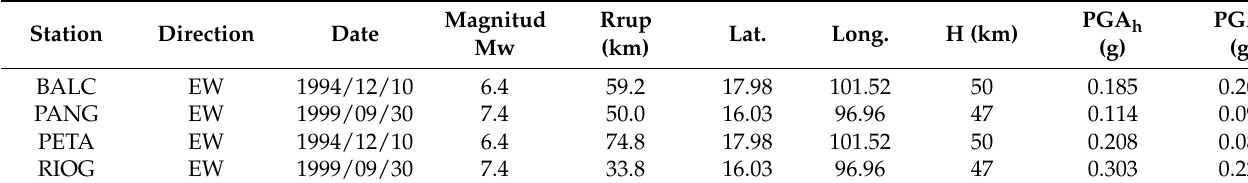
Table 10. Additional Mexican ground motions used in this section.